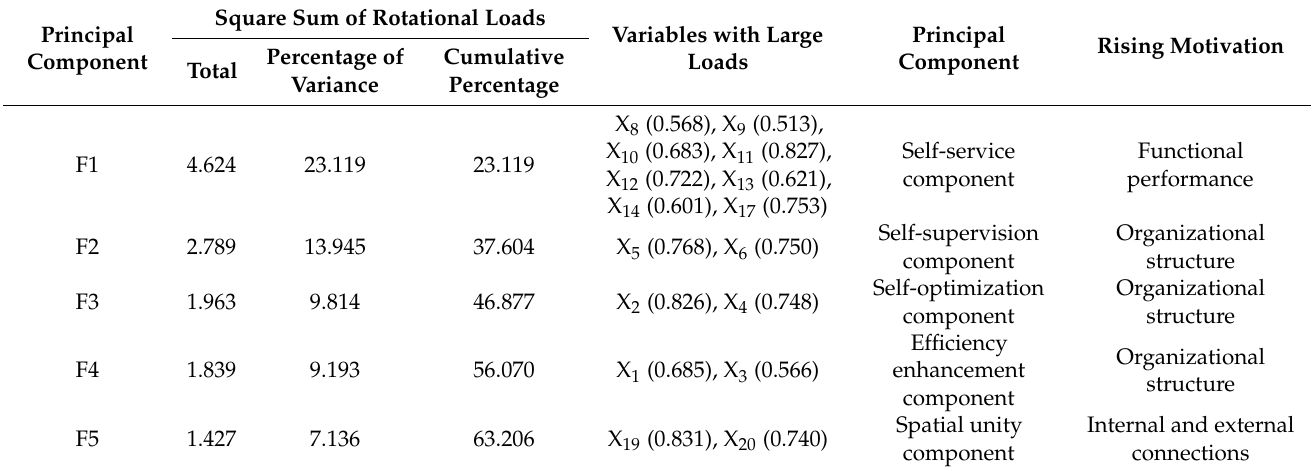
Table 5. Results of principle components analysis for the urban